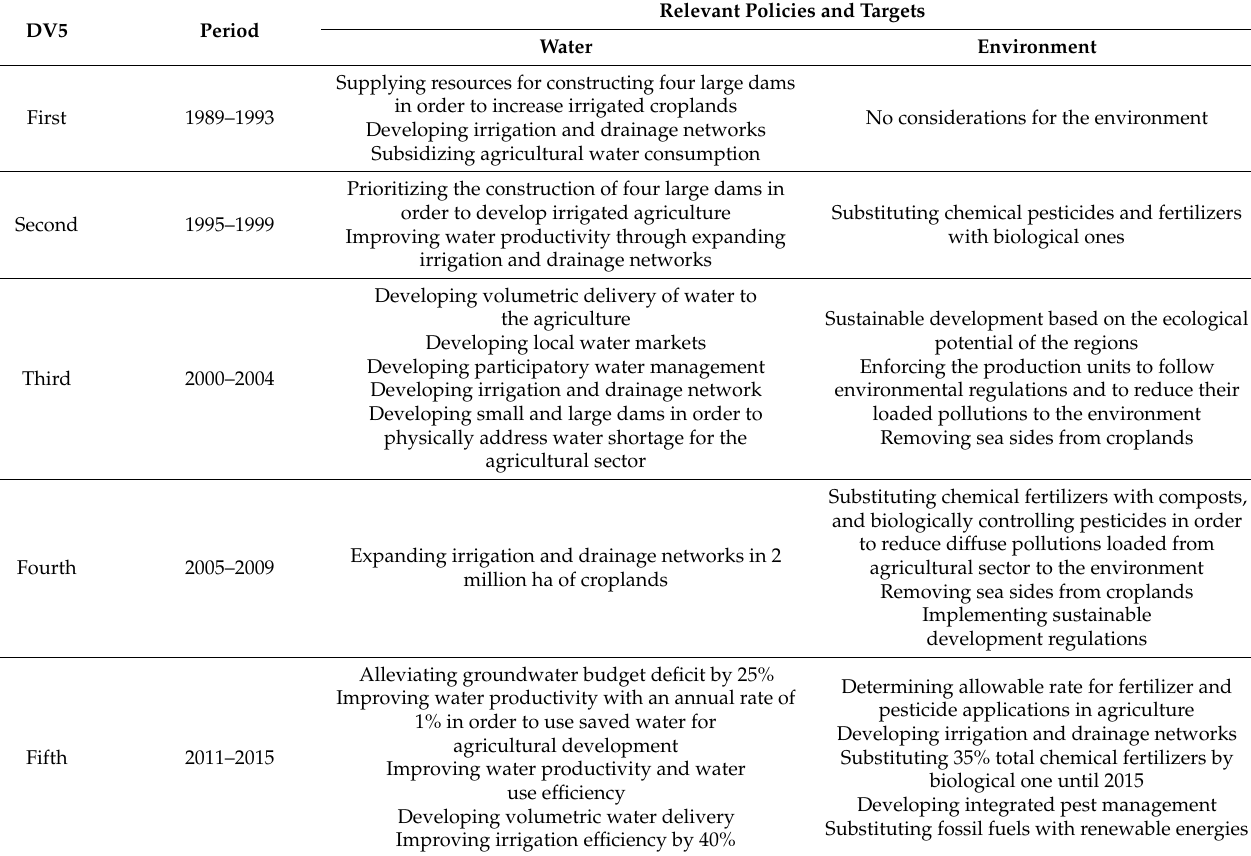
Table 3. Relevant policies/targets in first to 5th 5-year development plans (DV5) for developing water-related projects and conserving environment [32].